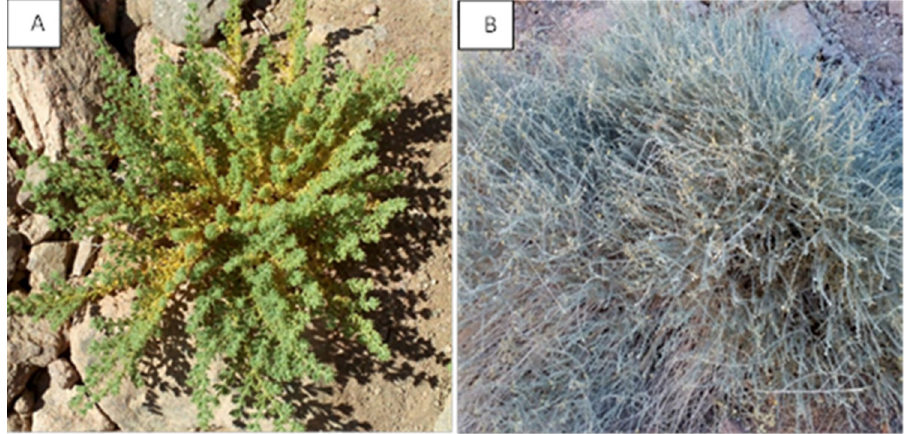
Figure 1. ( A ) Fagonia mollis Delile. and ( B ) Achillea fragrantissima